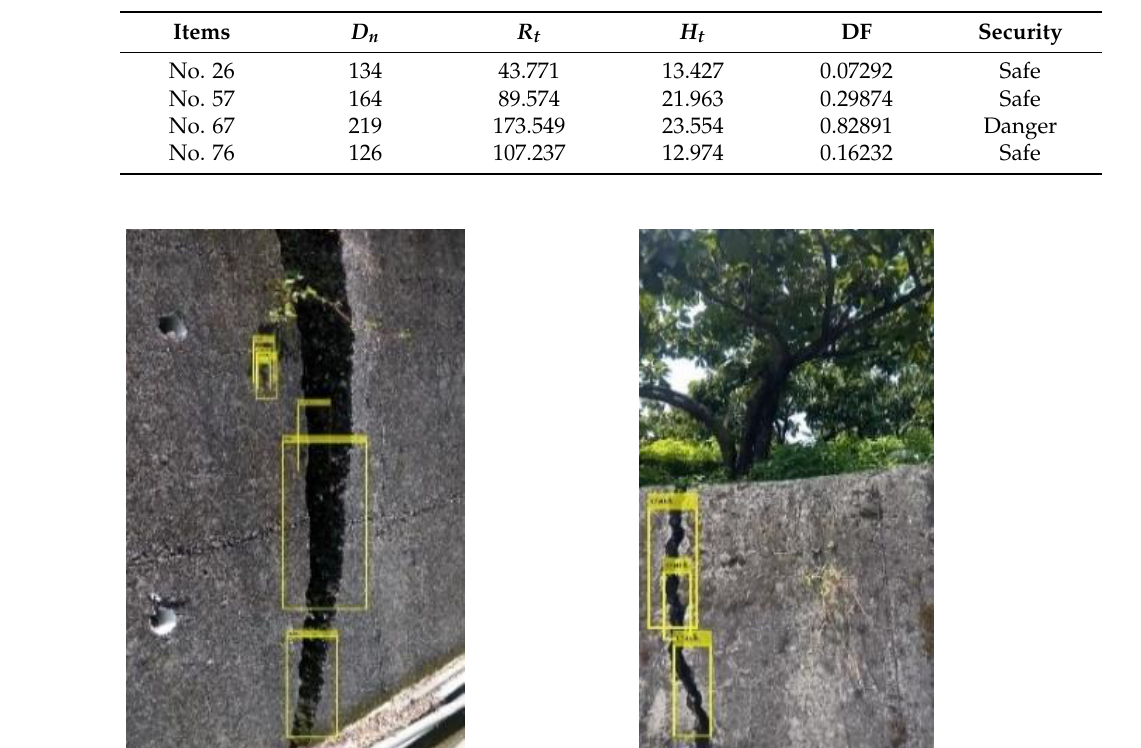
Table 2. Non-dangerous gap evaluate datasheet.